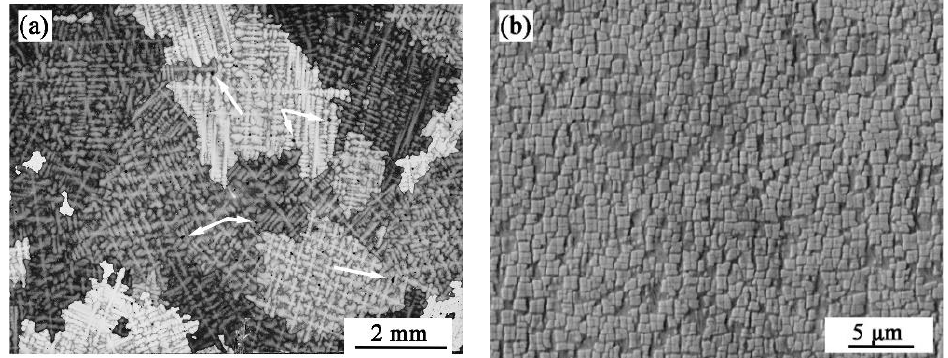
Figure 1. Microstructure of Inconel 713LC ( a ) coarse dendritic grains with small casting defects (white arrows) ( b ) detail of cubic γ′ precipitates.